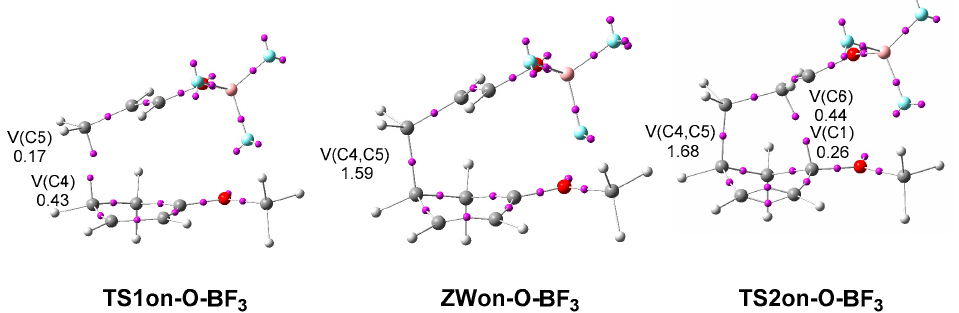
Figure 11. Representation of the ELF attractors of TS1on-O-BF 3, ZWon-O-BF 3 , and TS2on-O-BF 3 involved in the endo reaction path associated with the P-DA reaction between Cp 13 and complex 7-BF 3 . The electron populations in average number of electrons, e.